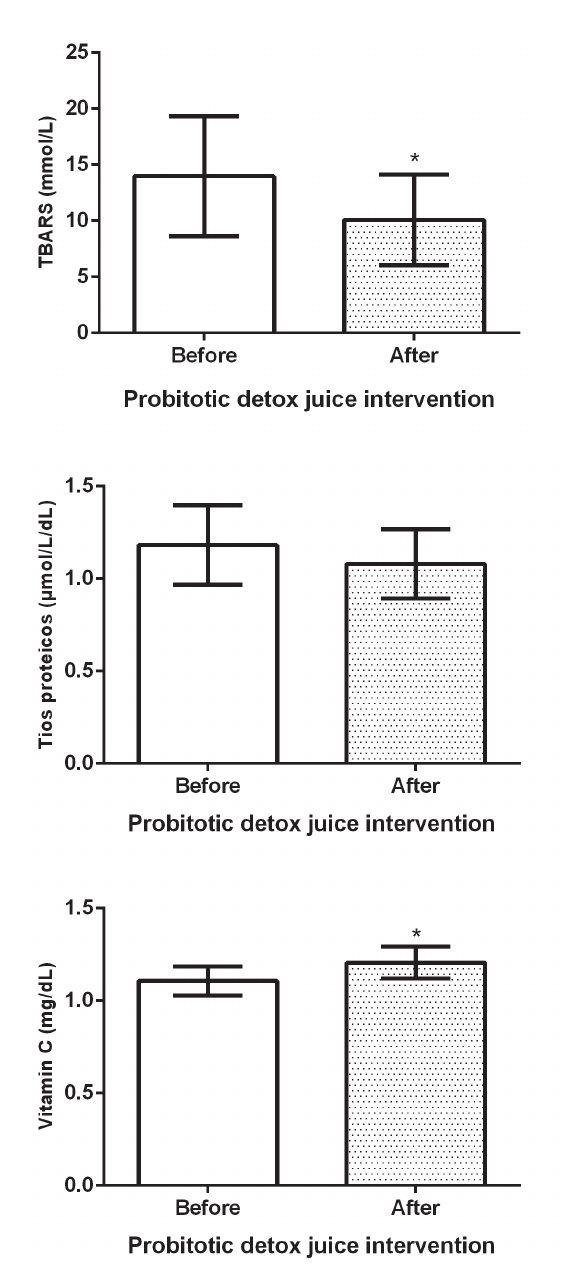
FIGURE 1 - Evaluation of oxidative stress markers in the studied population. A. GSH values (mol/L); B. TBARS values (mmol/L); C. Values of non-protein Tiols (µm/L); D. Protein thiol values (µ/mol/L/dL); E. Myeloperoxidase values (µmol); F. Vitamin C values (mg/dl). The data were presented as mean ± SD. The data were treated by Student›s t-test for parametric variables and Mann-Whitney for non-parametric